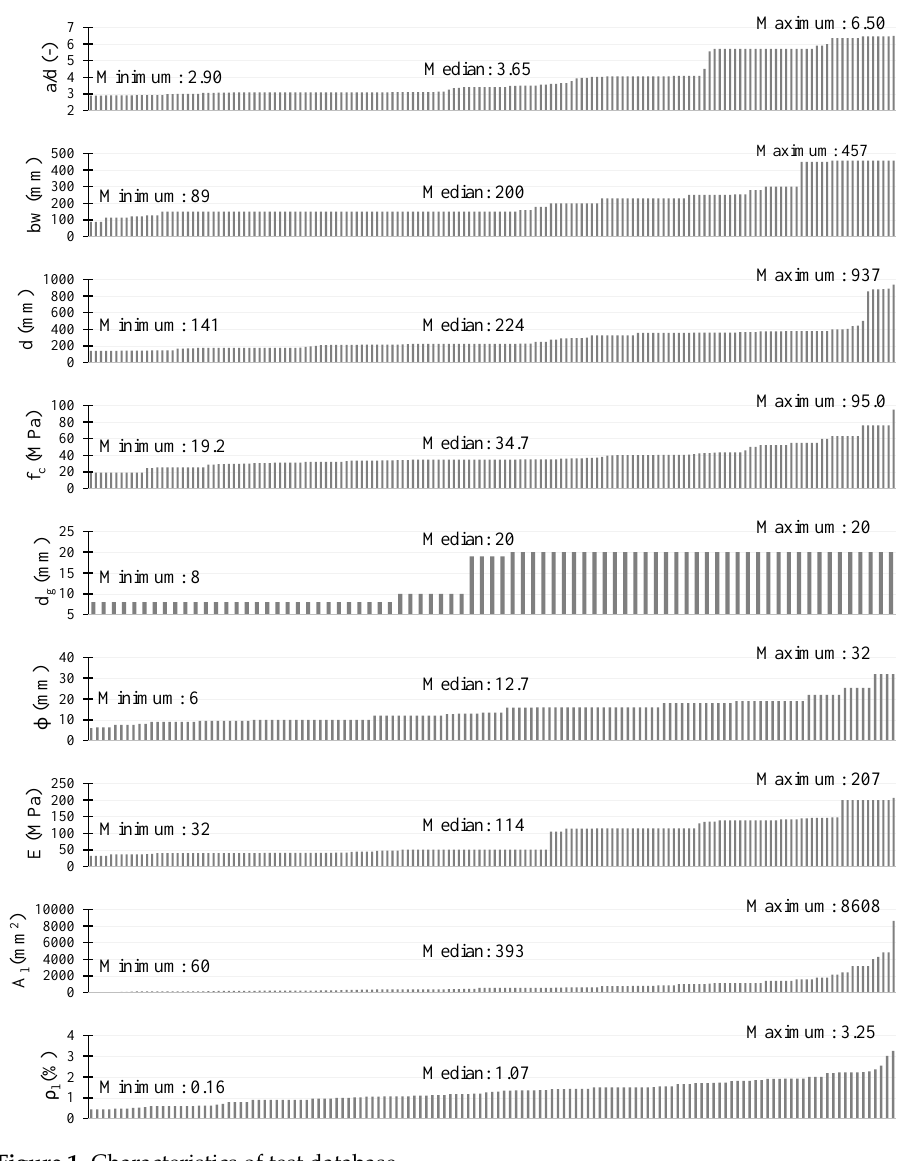
Figure 1. Characteristics of test database.